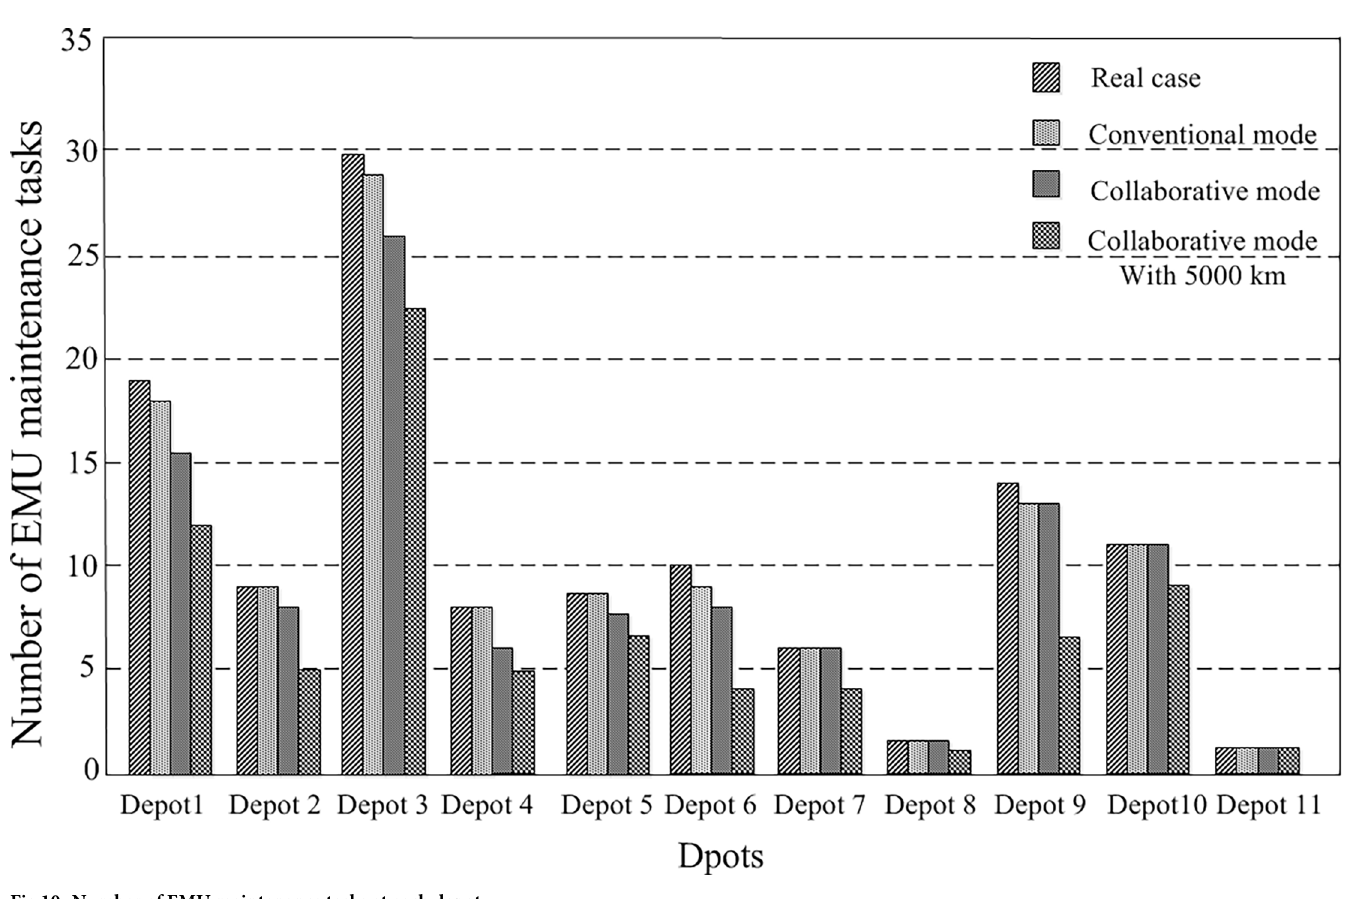
Fig 10. Number of EMU maintenance tasks at each depot.